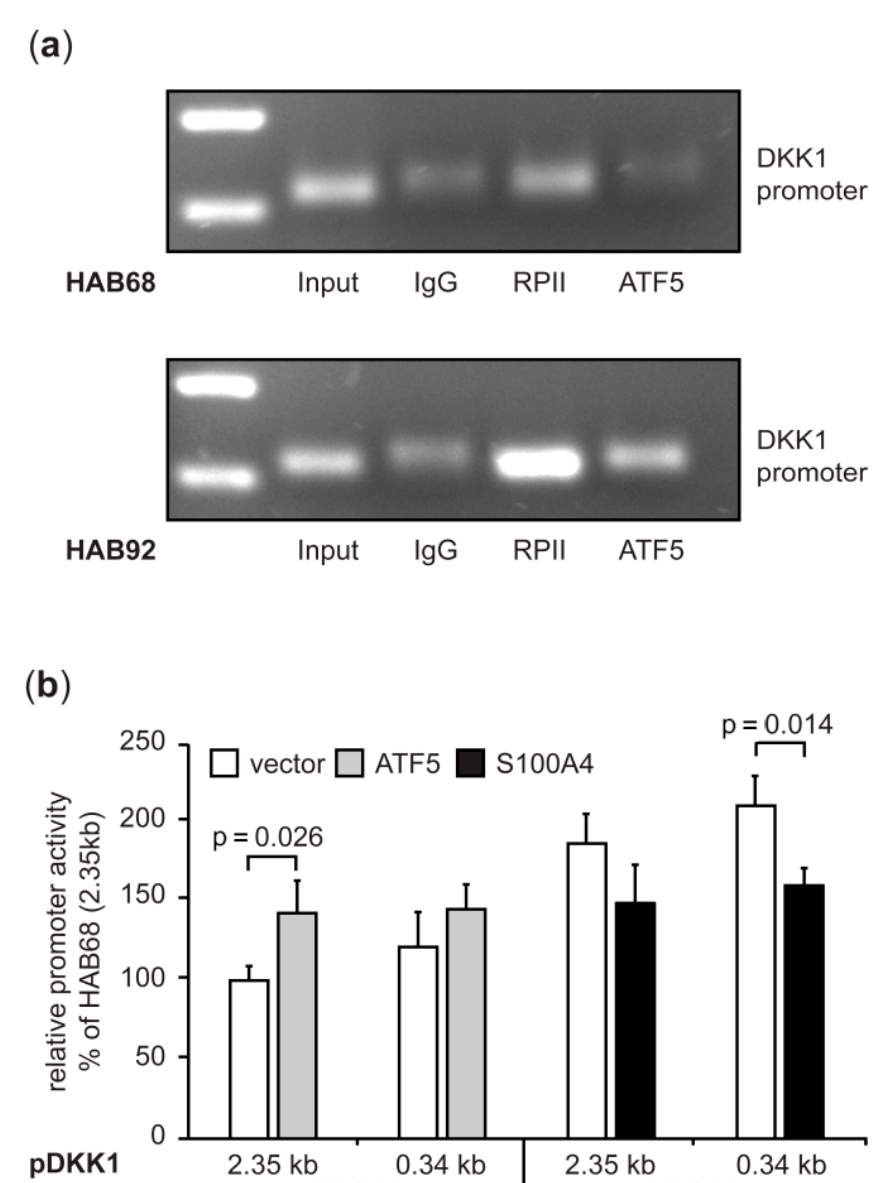
Figure 4. Expression regulation of DKK1 in CRC cells involves the transcription factor ATF5 and S100A4 but on different sites of the promoter. ( a ) ChIP assays of gene-specific pull-downs in HAB68 and HAB92 cells confirm the binding of ATF5 to the DKK1 promoter. Unspecific immunoglobulin served as the negative control and RNA polymerase II as an indicator of general DKK1 transcription. ( b ) Ectopic ATF5 expression in HAB68 cells increased DKK1 promoter-driven luciferase activity, while ectopic expression of S100A resulted in decreased reporter signal. DKK1 promoter fragments: − 2238 bp–+112 bp (2.35 kb); − 231 bp–+112 bp (0.34 kb).